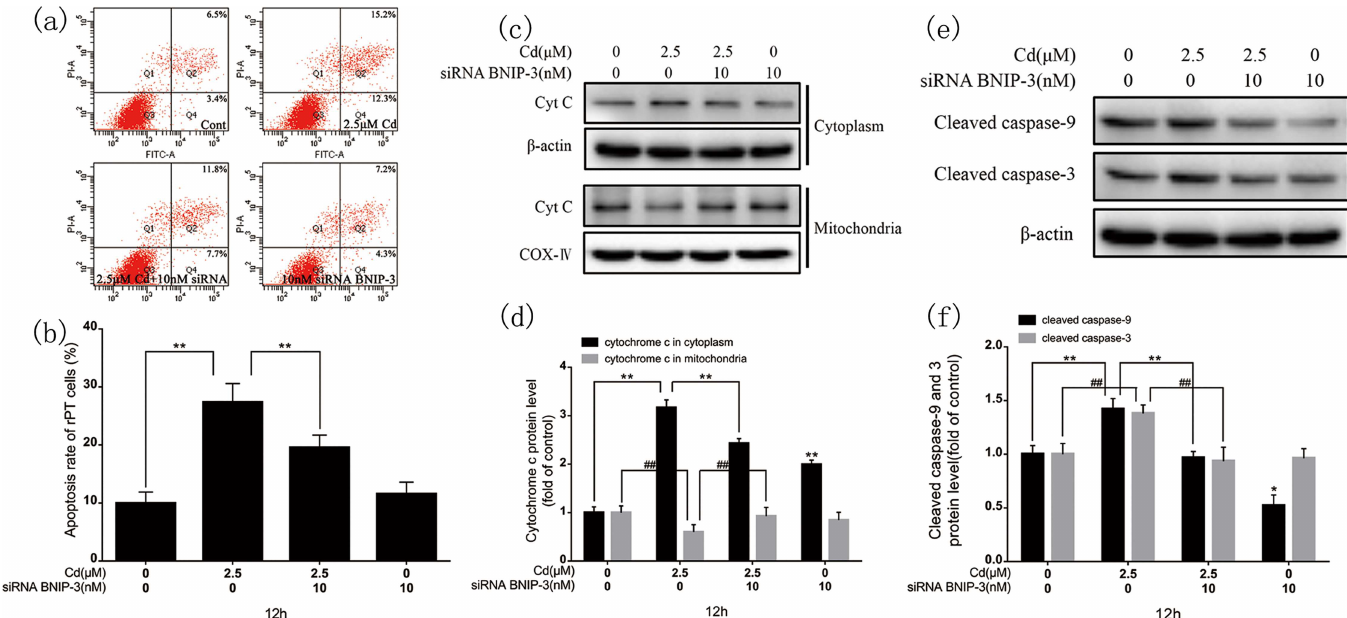
Fig 7. Effects of BNIP-3 silencing on cadmium-induced apoptosis, mitochondrial cyt c releaseto the cytoplasm, and changes in caspase-9 and caspase-3 expression. (a) Flow cytometry assessment of the rPT cell apoptosisrate after 12-h cadmiumand/or BNIP-3 siRNA treatment. (b) Percentage of apoptoticcells. (c, e) Representative images of cyt c, caspase-9,and caspase-3western blots. (d, f) Quantitative analysisof cyt c, caspase-9,and caspase-3; grayscaleof the control was set at 1. Results are from three independent experiments (mean ± SEM, n = 3). * P < 0.05, ** P < 0.01, and ## P < 0.01 as comparedto